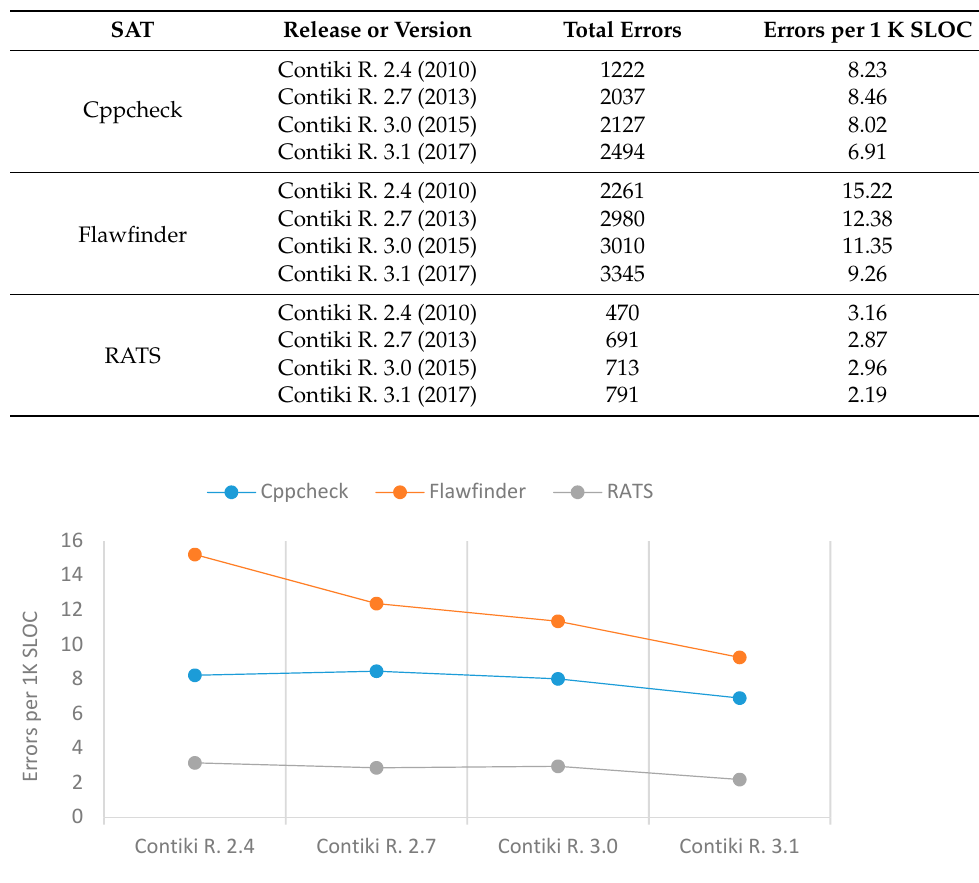
Figure 5. Errors per 1K SLOC of Contiki. Table 5. Total errors and errors per 1 K SLOC of Contiki.